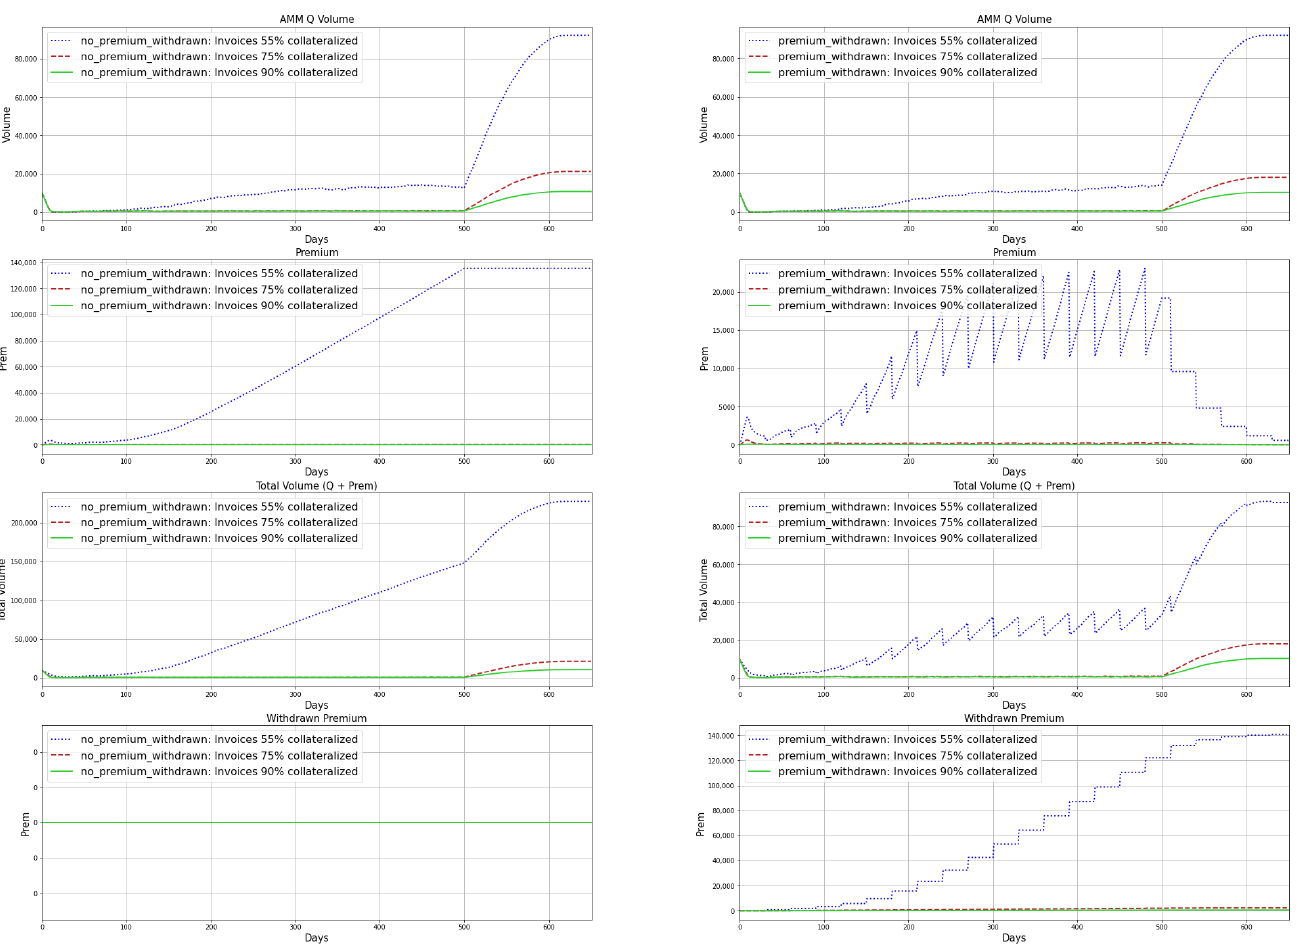
Figure 4. rkAMM Curves from simulation of scenario 5 and 30 days of withdrawal